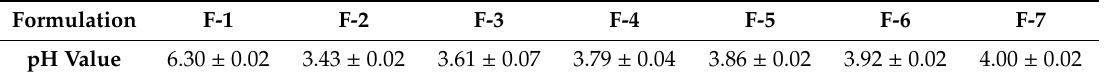
Table 1. The pH values determined for the semi-solid formulations tested ( p < 0.05).